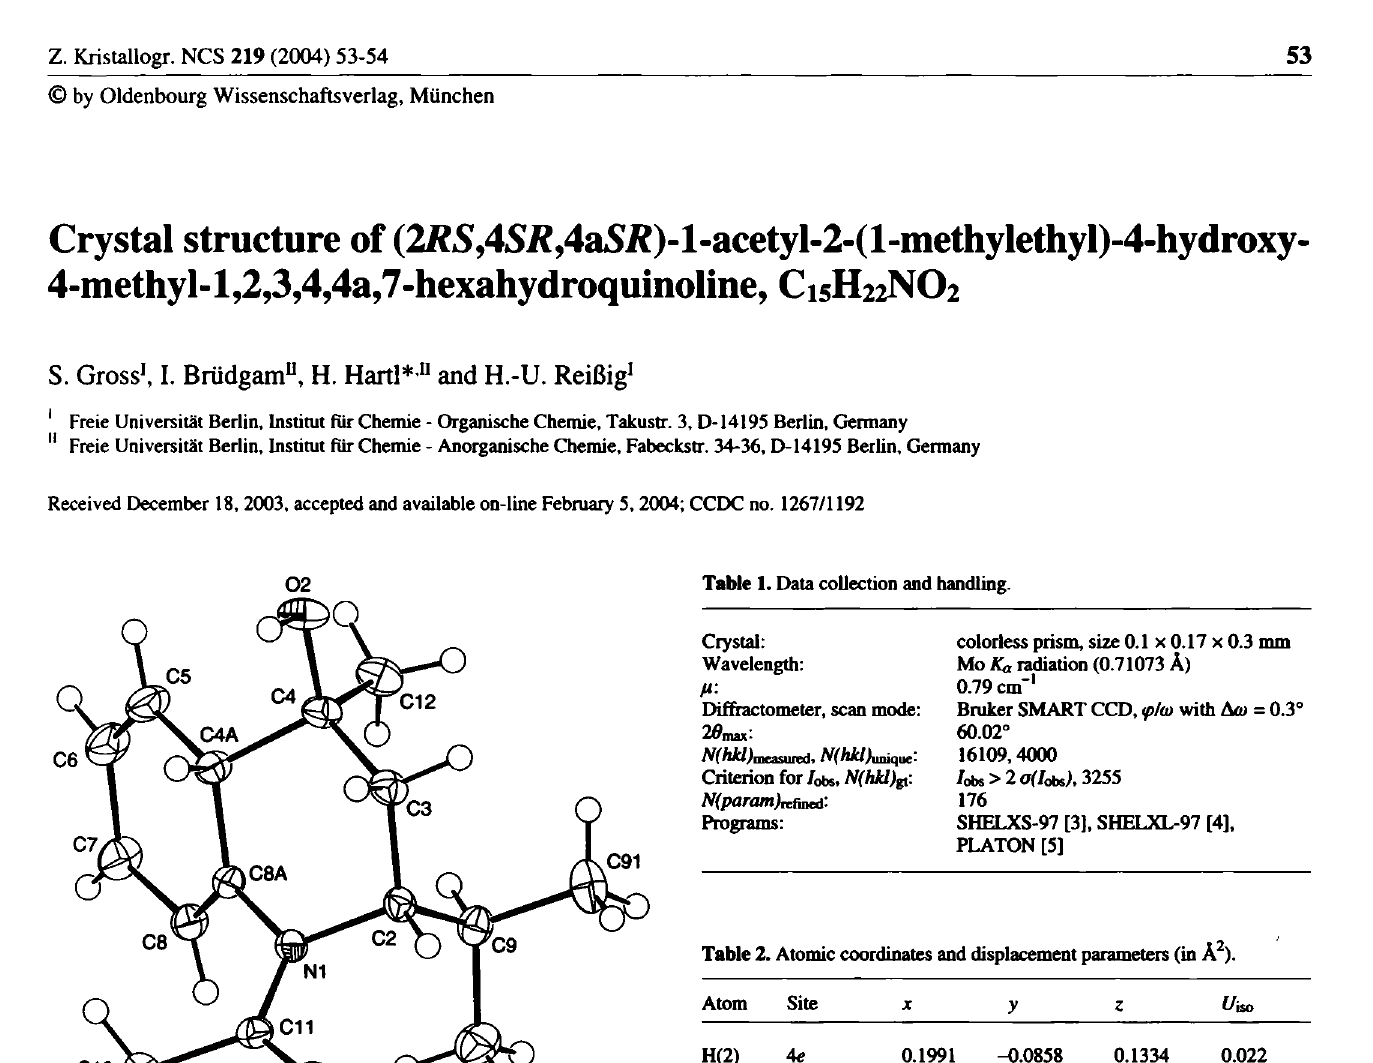
Table 2. Atomic coordinates and displacement parameters (in A 2